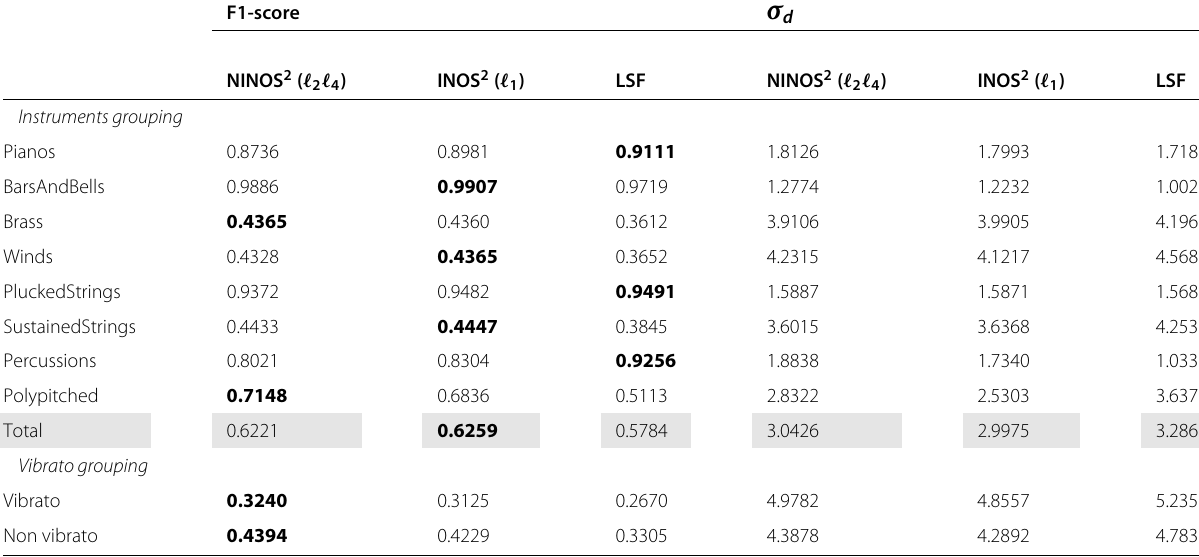
Table 3 NOD performance measures for P dataset